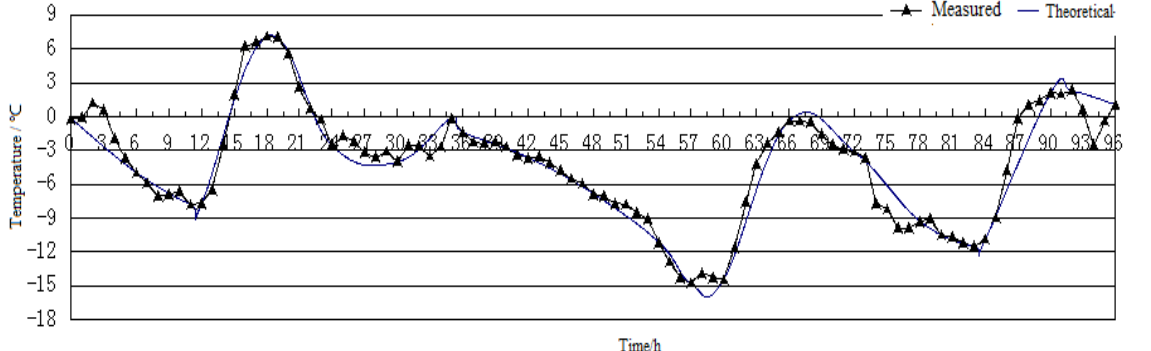
Figure 1. Comparison of measured and theoretical temperature of Miyun station in Beijing.